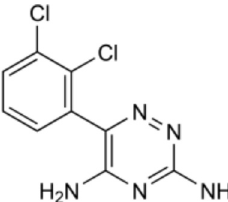
FIGURE 1 – The chemical structure of